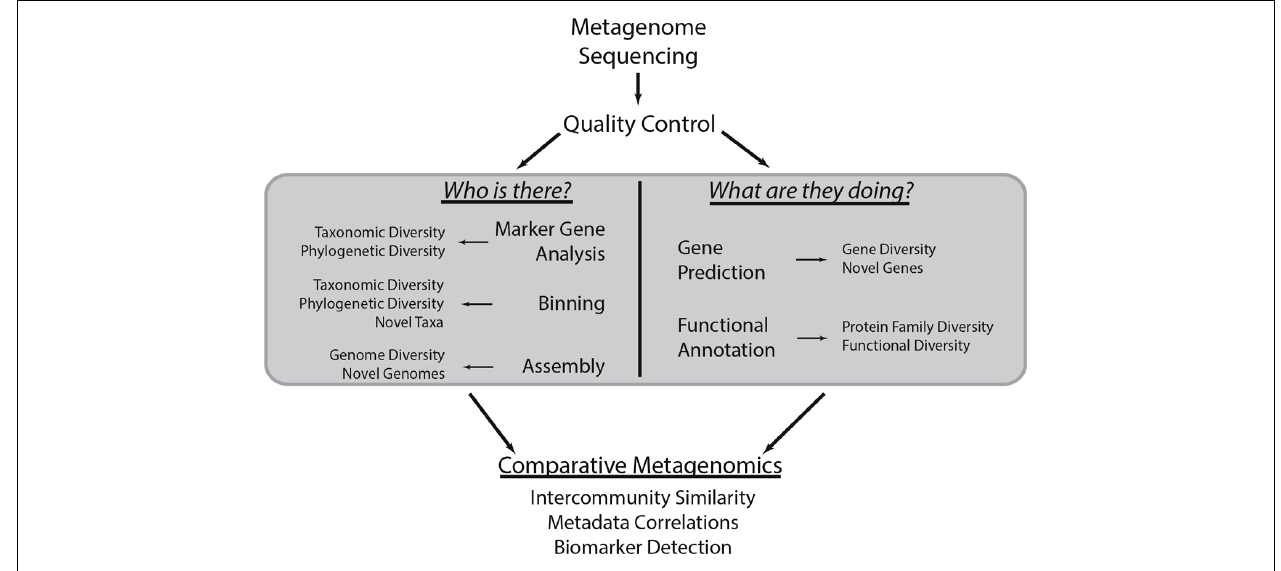
Metagenomes can also be subject to gene prediction and functional annotation, which can be used to characterize the biological functions associated with the community and identify novel genes. The results of these various analyses can be compared to those obtained through analysis of other metagenomes to quantify the similarity between communities, determine how community diversity scales